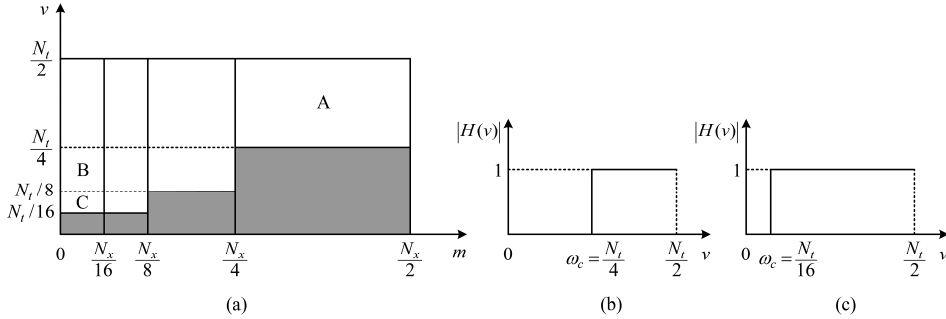
Figure 3. Analysis of our pyramidal 3D filter utilizing the three-scale 3D DWT: ( a ) Scheme of a m ´ v slice, where white parts denote support regions and gray parts denote non-support regions; ( b ) one-dimensional (1D) ideal high pass filters (IHPFs) along the v axis when N x { 4 ă m ă N x { 2; ( c ) 1D IHPFs along the v axis when 0 ă m ă N x {